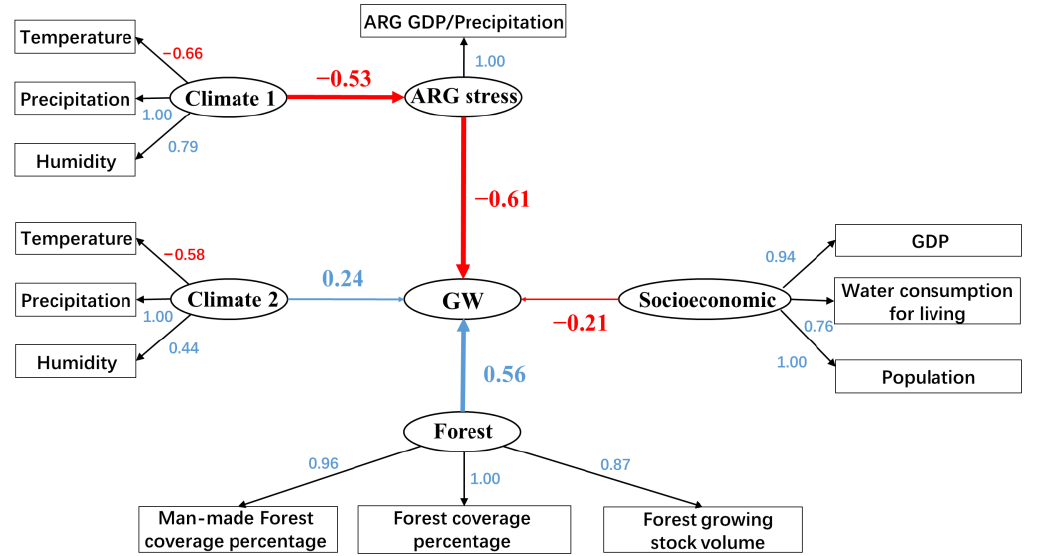
Figure 3. Structural equation model for groundwater-drivers relations.